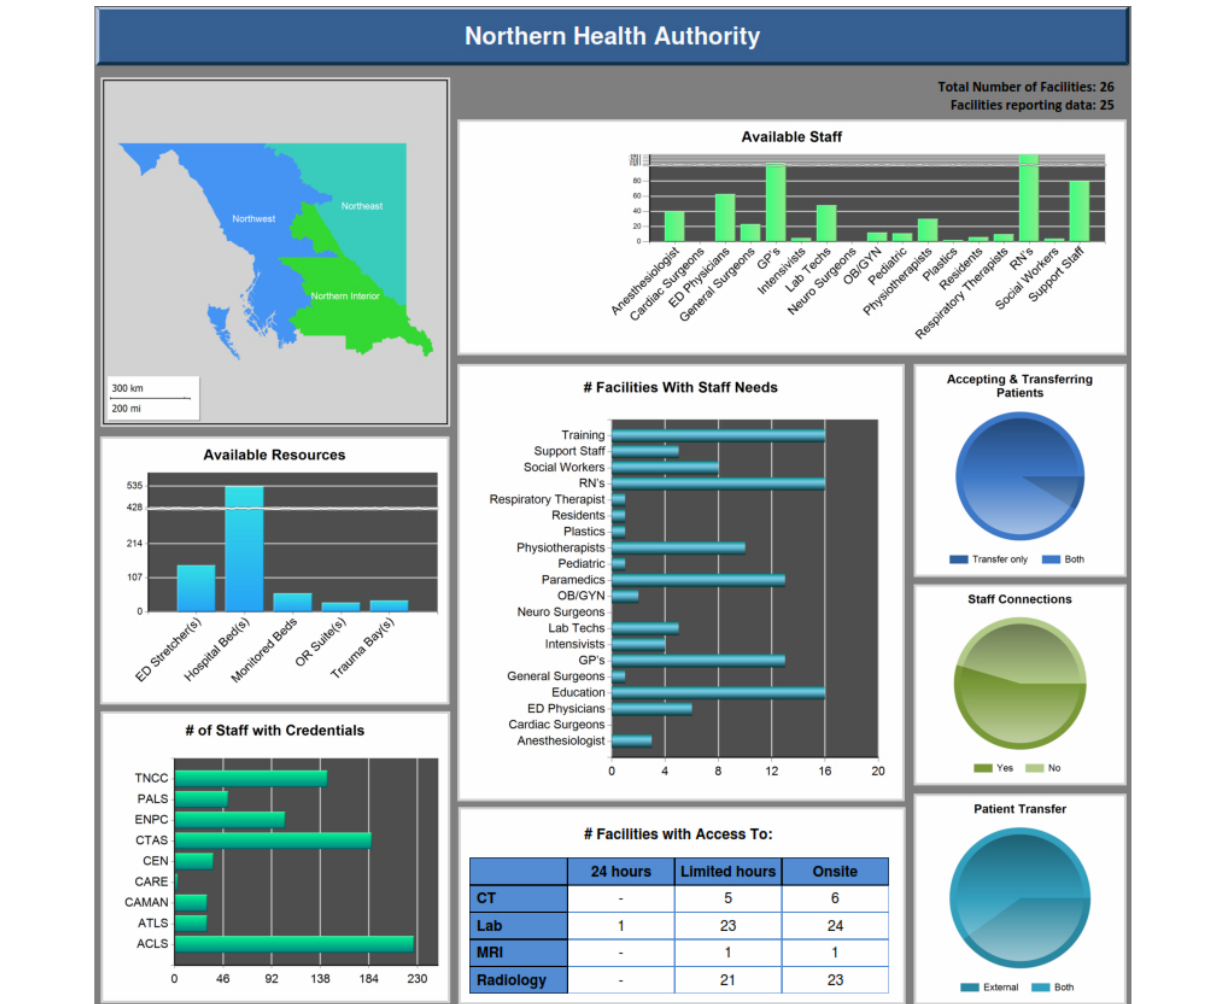
Figure 6. Critical Care